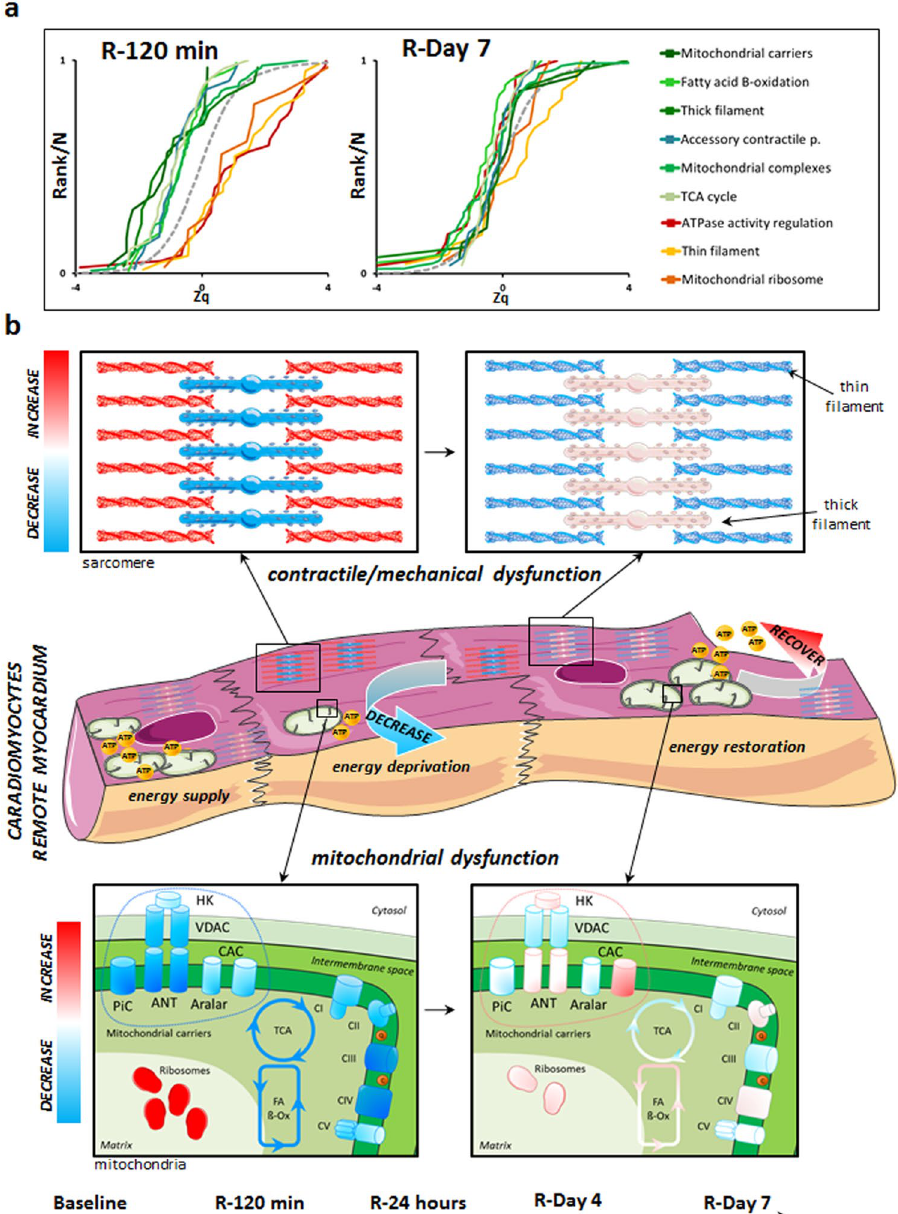
Figure 7. Affected functional processes in sarcomeres and mitochondria of the remote myocardium. ( a ) Cumulative distributions of all Zq values from proteins in the categories depicted in (Supplementary Figure S3) after 120 min (left) or 7 days (right) of reperfusion; for clarity, all proteins belonging to mitochondrial electron transport chain (ETC) complexes are grouped into one category. ( b ) Outline of the mechanical uncoupling within the contractile machinery and the transient decrease in processes crucial for energy production (tricarboxylic acid (TCA) cycle, fatty-acid beta-oxidation, mitochondrial complexes III and IV) and energy transfer and supply (mitochondrial substrate/solute carrier proteins). For clarity, mitochondrial complexes are drawn as simple entities, neglecting their complex structures. Graphical elements in Fig. 7 were adapted from the Servier Medical Art Powerpoint image bank. Servier Medical Art by Servier (http://www.servier.com/Powerpoint-image-bank) is licensed under a Creative Commons Attribution 3.0 Unported License